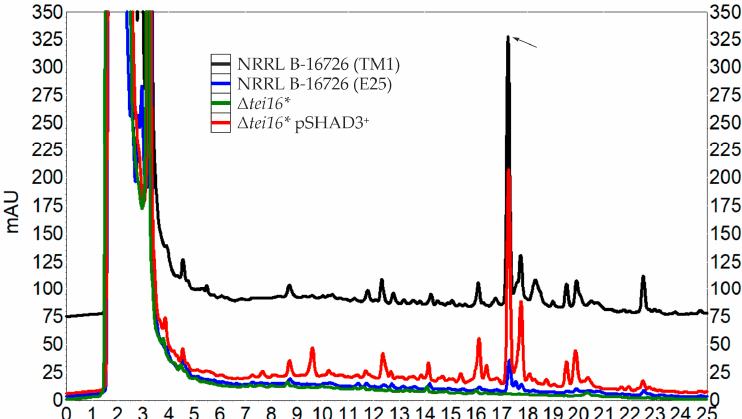
Figure 5. Restoration of teicoplanin production phenotype in A. teichomyceticus Δ tei16 * upon intro- duction of pSHAD3, as revealed with HPLC. Black and blue chromatograms show the production profile of A. teichomyceticus NRRL B-16726 in TM1 and in E25, supplemented with 1g/L of L -valine, after 96 h cultivation, the red chromatogram shows the production profile of A. teichomyceticus Δ tei16* pSHAD3 + in E25 added with 1g/L of L -valine at the same cultivation time point, while the green chromatogram demonstrates the absence of teicoplanin production in A. teichomyceticus ∆ tei16* cultivated in TM1 for 96 h. No production (superimposable profiles not shown) was observed with A. teichomyceticus ∆ tei16* pSHAD3 + in TM1 and with A. teichomyceticus ∆ tei16* in E25 + 1 g/L L -valine. Teicoplanin main peak (factor A 2–2 ) is indicated with a black arrow (for the chromatogram of commercial teicoplanin standard, please refer to Figure S2b).